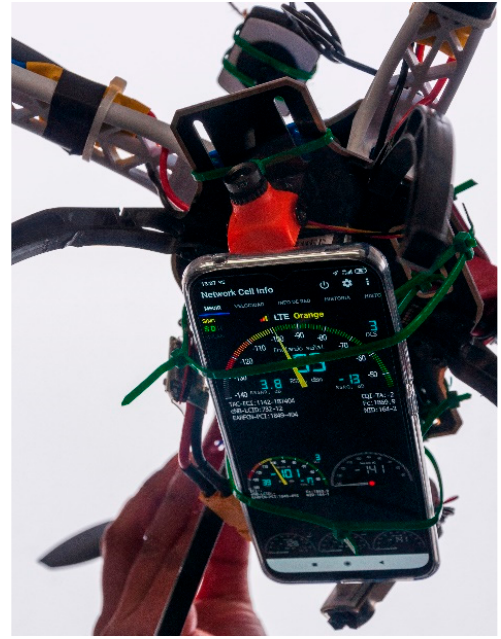
Figure 7 . Xiaomi mounted with the UAV. Figure 7. Xiaomi mounted with the